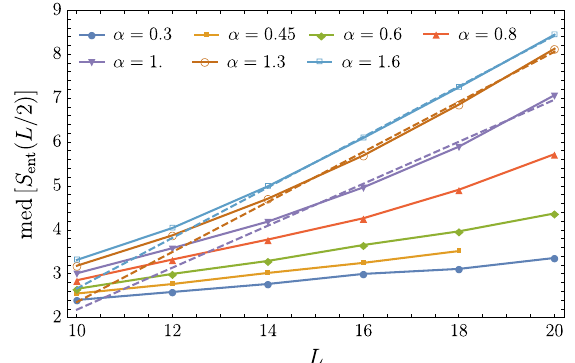
FIG. 10. Median value of the half-chain entanglement entropy, S L= 2 Þ , for the S 0 ¼ 0 sector and α ∈ f 0 . 3 ; 0 . 45 ; 0 . 6 ; 0 . 8 ; ent ð 1 . 0 ; 1 . 3 ; 1 . 6 g (bottom to top). Linear fits, performed on the L ≥ 14 points, are shown when their slope is close to that expected for an ergodic phase. Entanglement entropy for the higher disorder values is strongly